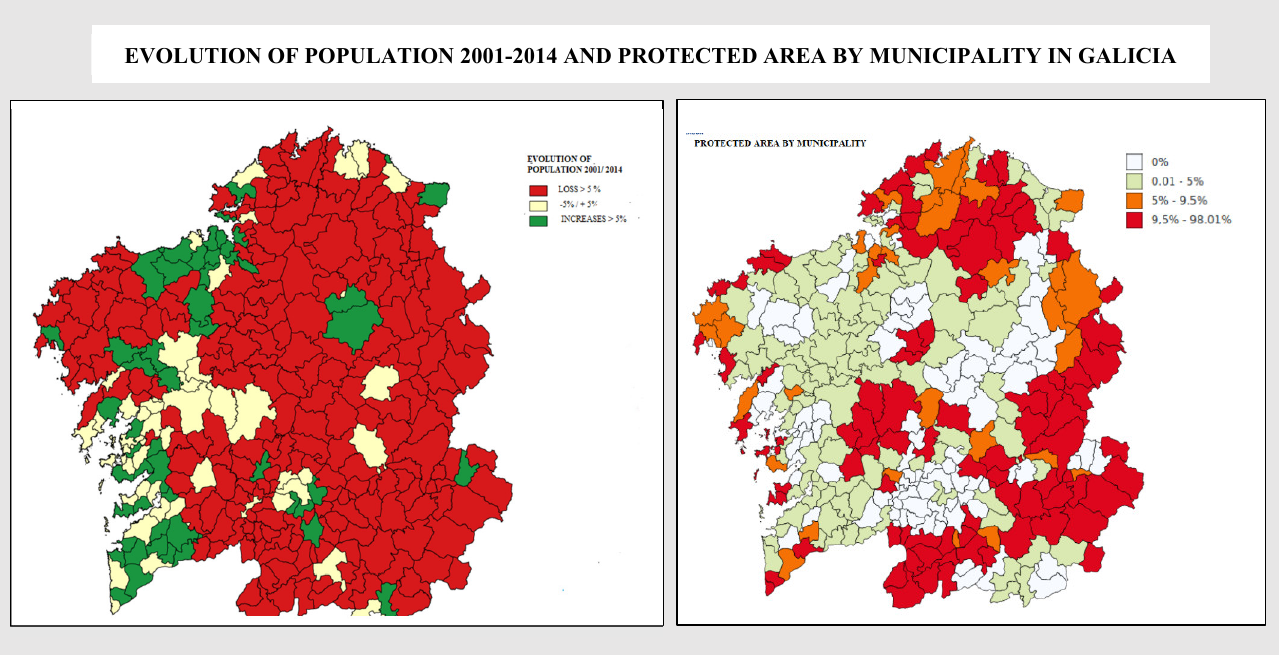
Figure A1. Evolution of population (2001–2014) and protected area by municipality.